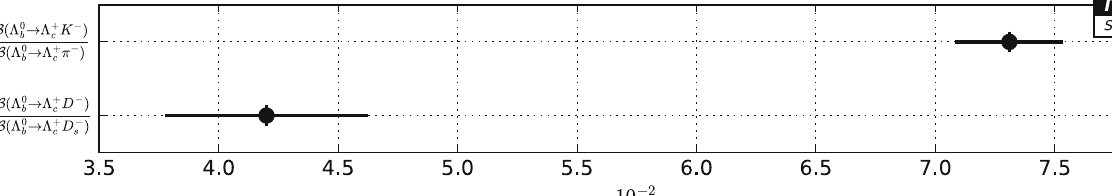
Fig. 174 Summary of the averages from Table